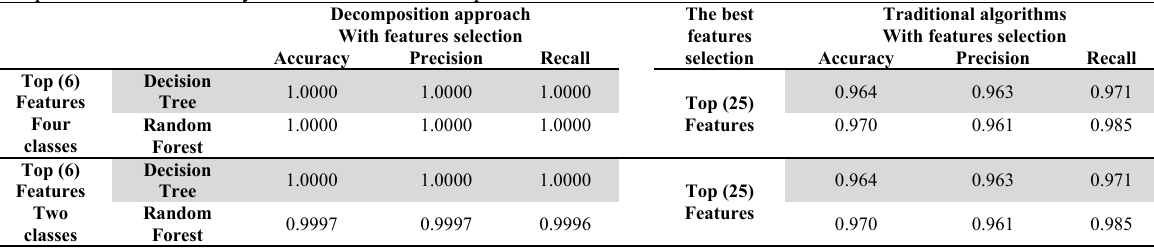
Comparison of the accuracy in the first and second phases after feature selection